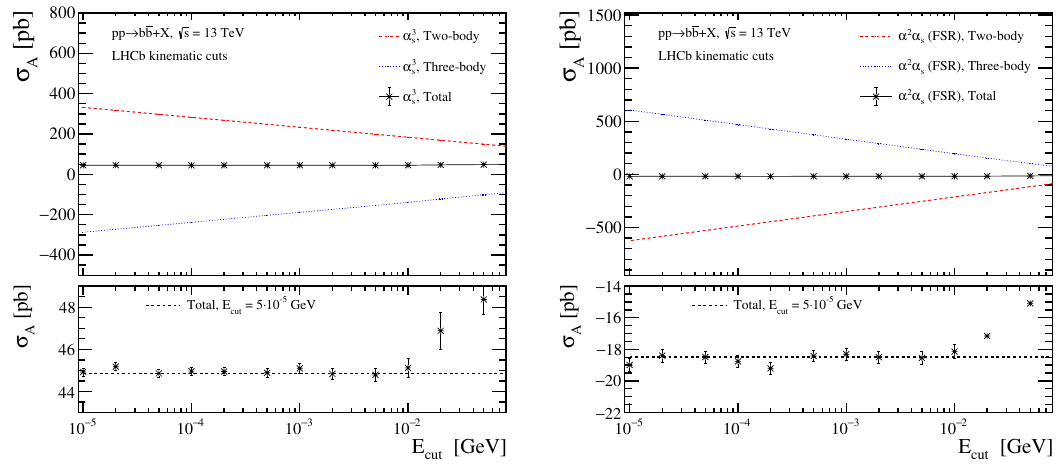
Figure 17 . Dependence on the slicing parameter E cut which de(cid:12)nes the soft region of the three- body corrections. Results are shown for the asymmetric b (cid:22) b cross section within m adopting the experimental selections (2.2). The left panel illustrates the O ( (cid:11) 3 the right panel depicts the O ( (cid:11) 2 (cid:11) s ) corrections to the massive (cid:12)nal-state quark